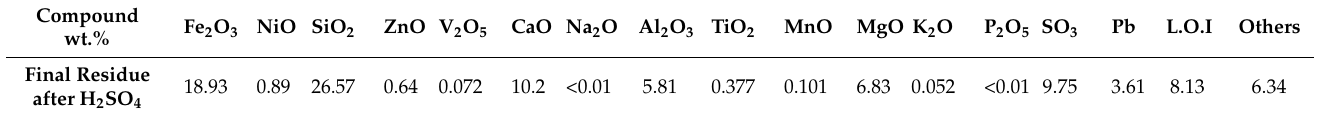
Table 2. Overall chemical analysis of sulfuric acid solid residue